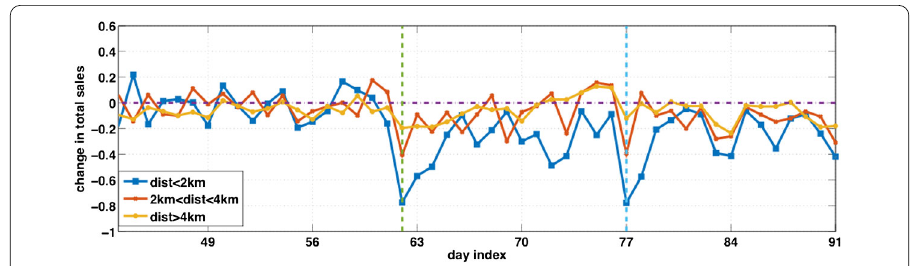
Figure A6 The impact of a series of protest events on total sales, in neighborhoods within 2 km (blue), from 2 to 4 km (red), and above 4 km (orange) from the protest site. The dash-dot purple line indicates zero change, and the dashed green and cyan lines indicate Day 62 and Day 77,